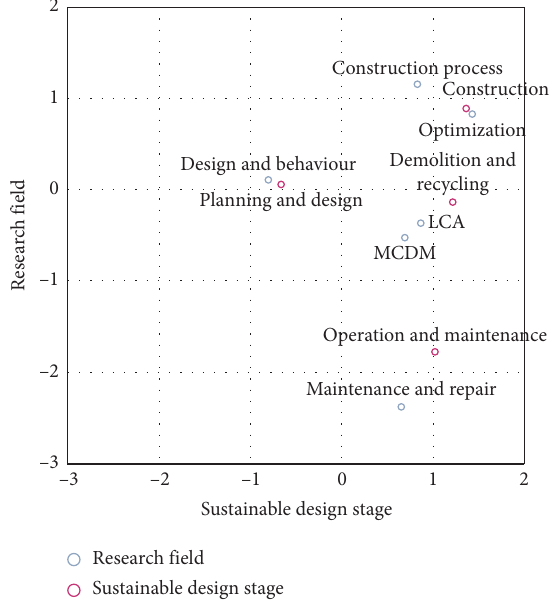
Figure 5: Simple correspondence analysis for research field and sustainable design stages.